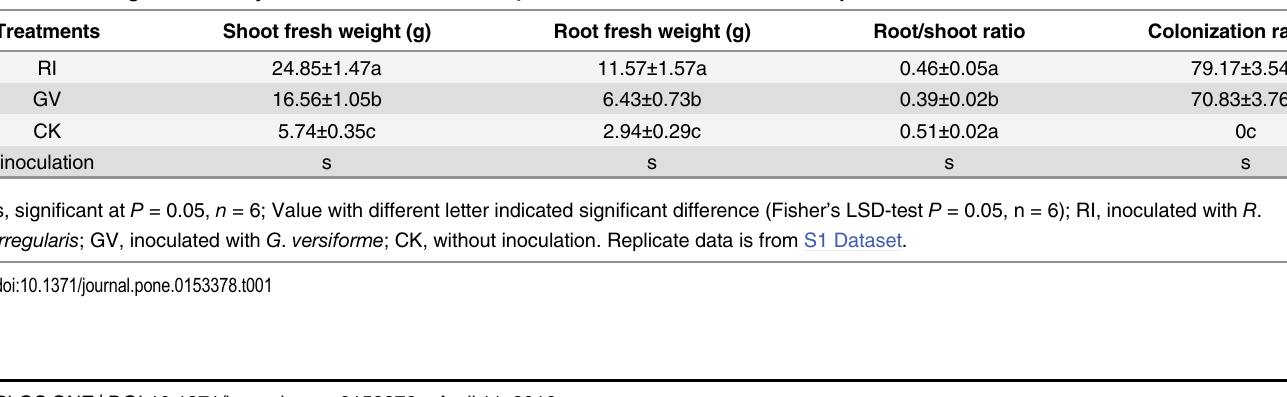
Table 1. Plant growth and mycorrhizal colonization of R . pseudoacacia 12 weeks after transplant. Treatments Shoot fresh weight (g) RI